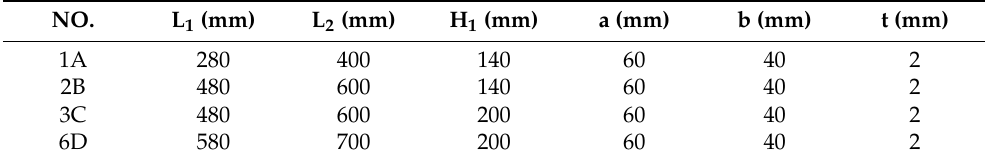
Table 1. Four groups of sample-related size